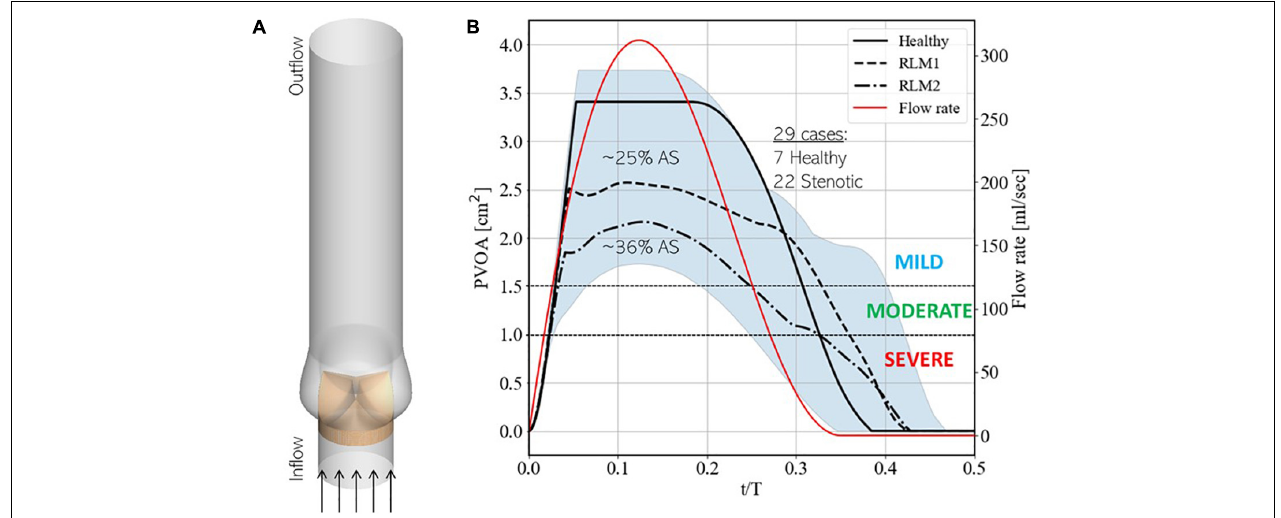
FIGURE 6 | (A) Schematic showing simulation setup and (B) instantaneous upper and lower bounds on projected valve open area (PVOA) in the training dataset, indicated by the blue shaded region, with three baseline simulations, indicated using solid, dashed and dashed-dot black lines. These simulations correspond to cases 7, 13, and 20, respectively, from Supplementary Table 1 in Appendix A. Additionally, the secondary y -axis describes the instantaneous flow-rate profile used to drive